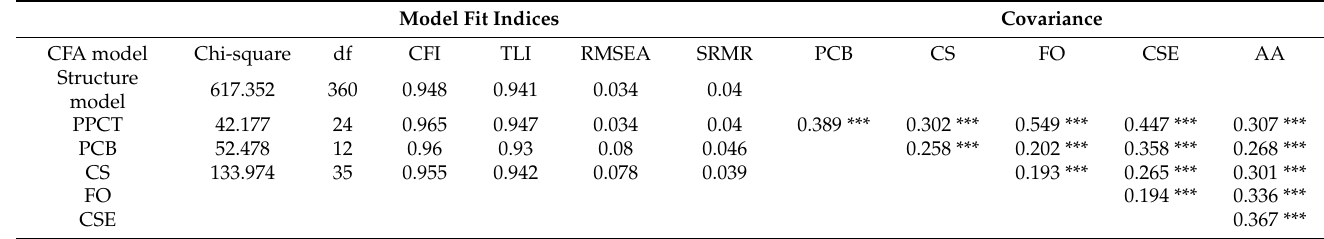
Table 2. Model fit indices and covariance of measurement model and structure